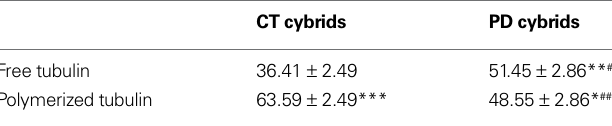
Table 1 | Percentage of free and polymerized